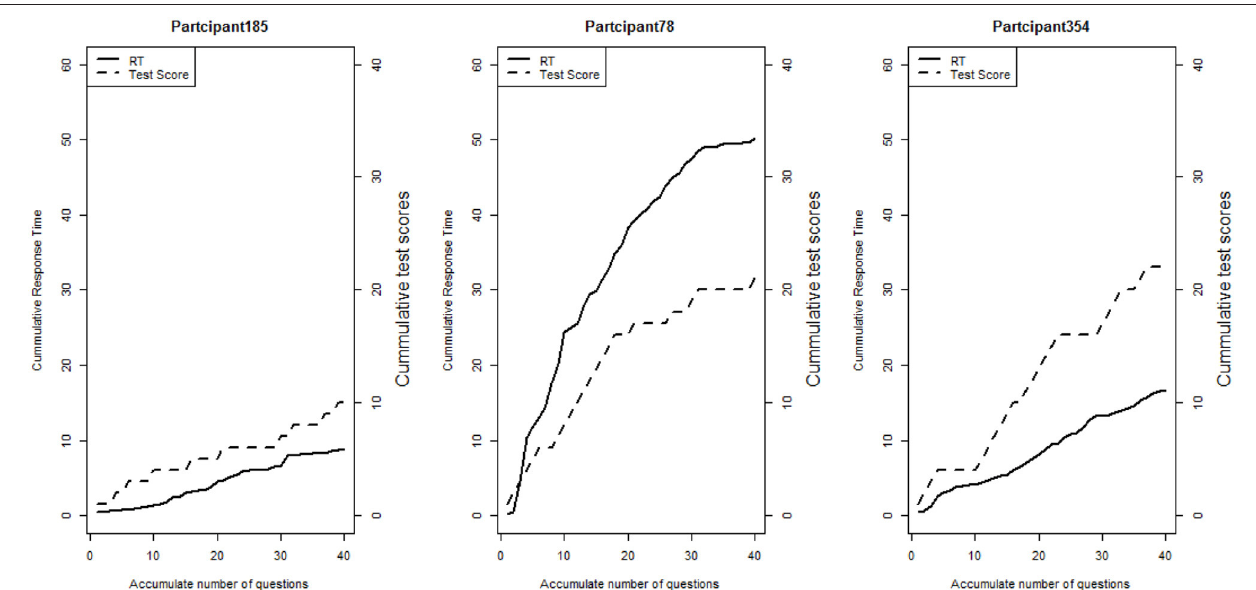
FIGURE 4 | Line plots of three participants’ cumulative total scores and total response times at the end of each